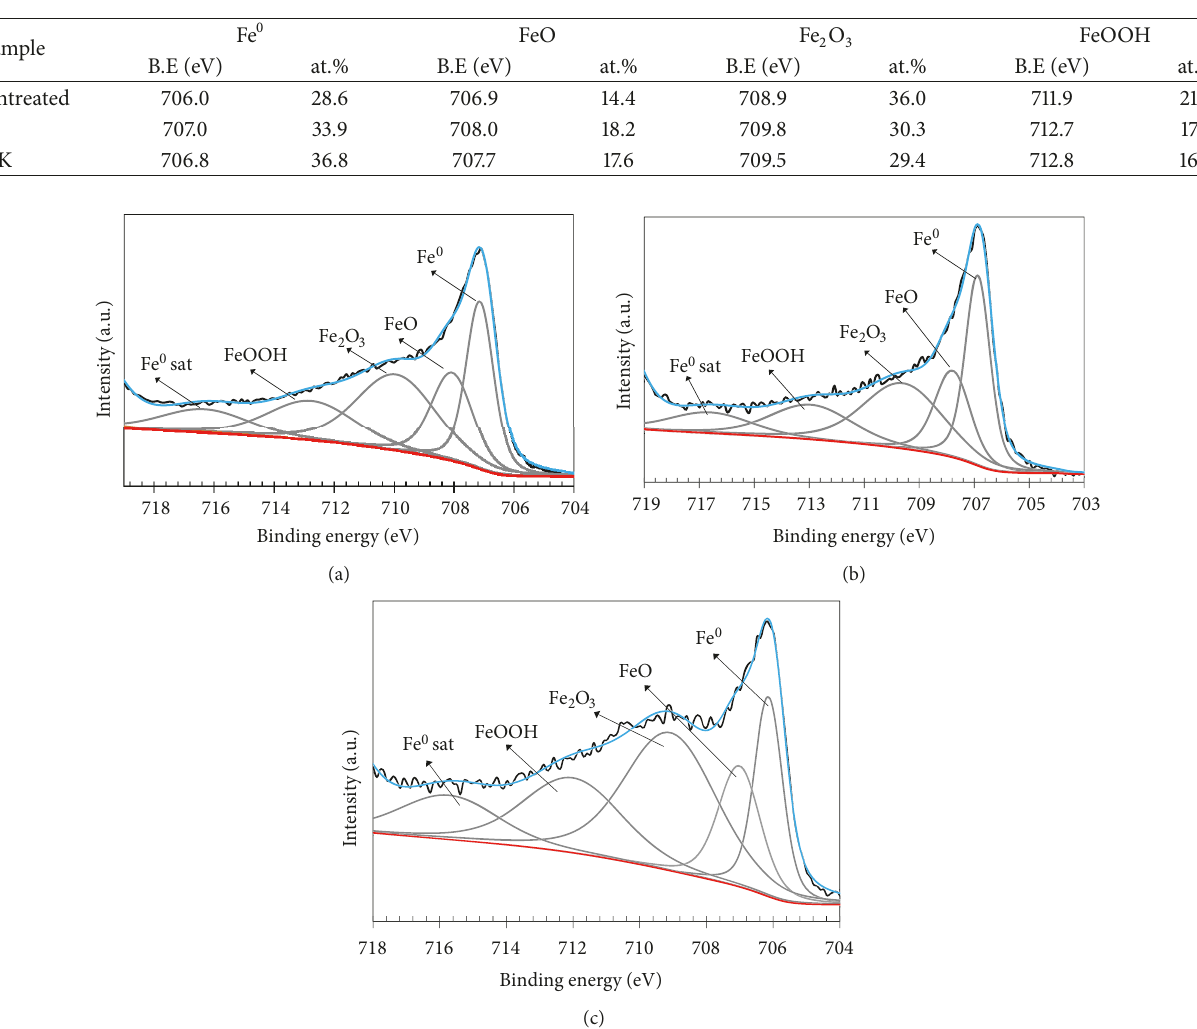
Figure 3: XPS spectra for the Fe2p 3/2 core levels: (a) N; (b) NK; and (c) untreated